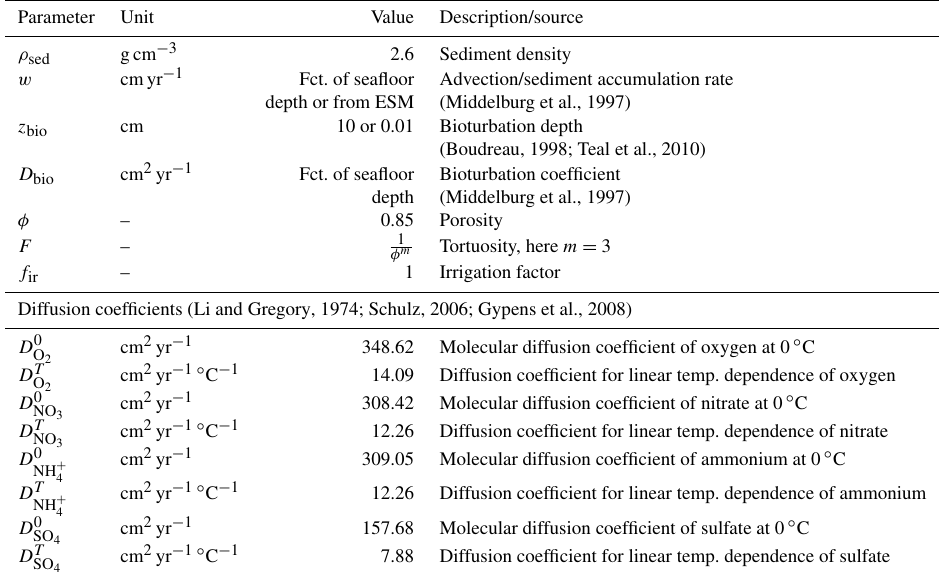
Table B1. Sediment characteristics and transport